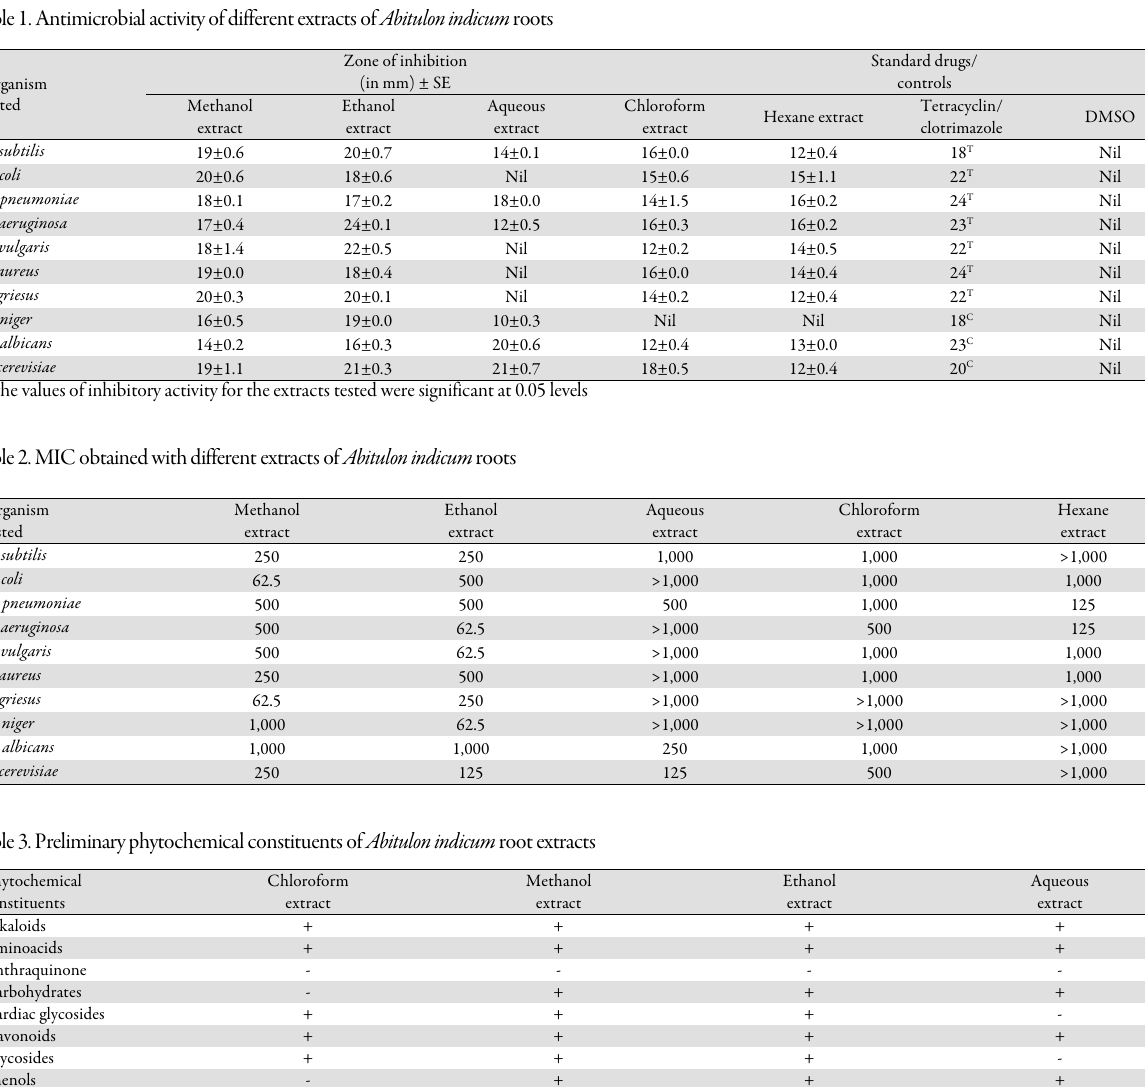
Zone of inhibition (in mm) ± SE